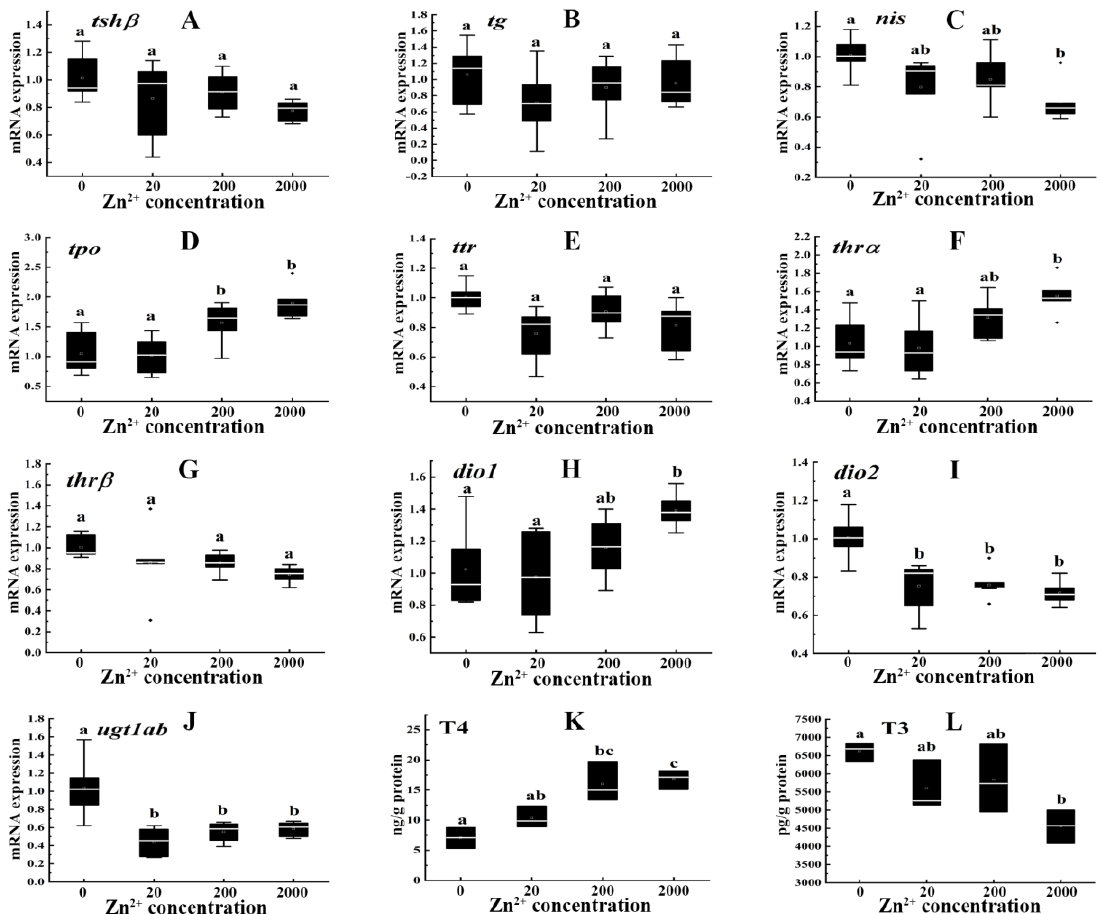
Figure 2. Transcription levels of tsh β ( A ), tg ( B ), nis ( C ), tpo ( D ), ttr ( E ), thr α ( F ), thr β ( G ), dio1 ( H ), dio2 ( I ), ugt1ab ( J ) and contents of T4 ( K ), T3 ( L ) in zebrafish embryos/larvae that were treated with Zn 2+ (0, 20, 200 and 2000 μg/L) for 120 h. Data are shown as mean ± SD ( n = 6). Different letters denote the significant differences between groups.